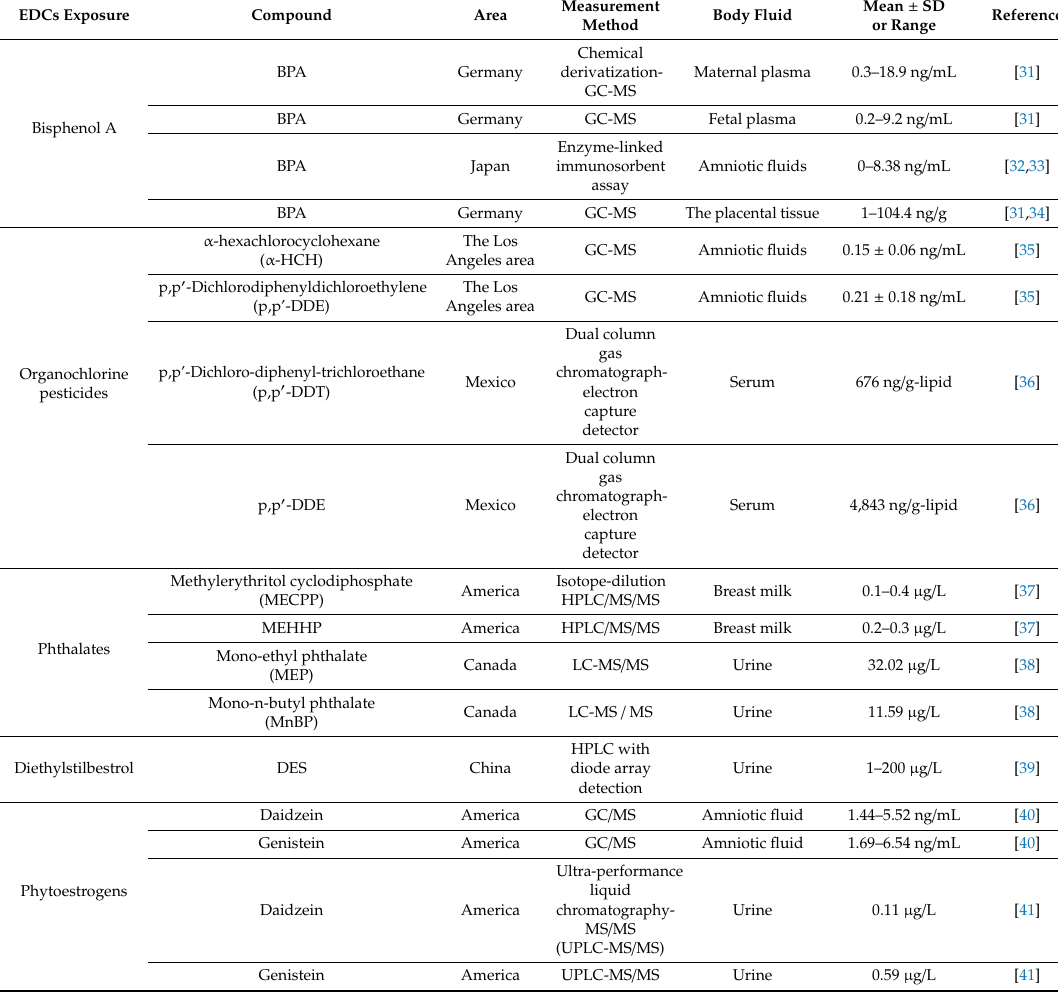
Table 1. Detection methods of some endocrine disruptors in maternal body